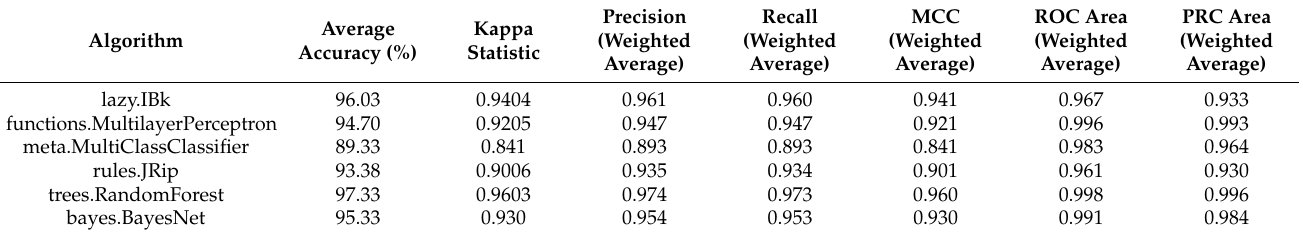
Table 6. The performance metrics of the classification of unstored black currants and black currants stored in the refrigerator (one and two weeks) based on models developed based on selected textures from color space XYZ using different algorithms.